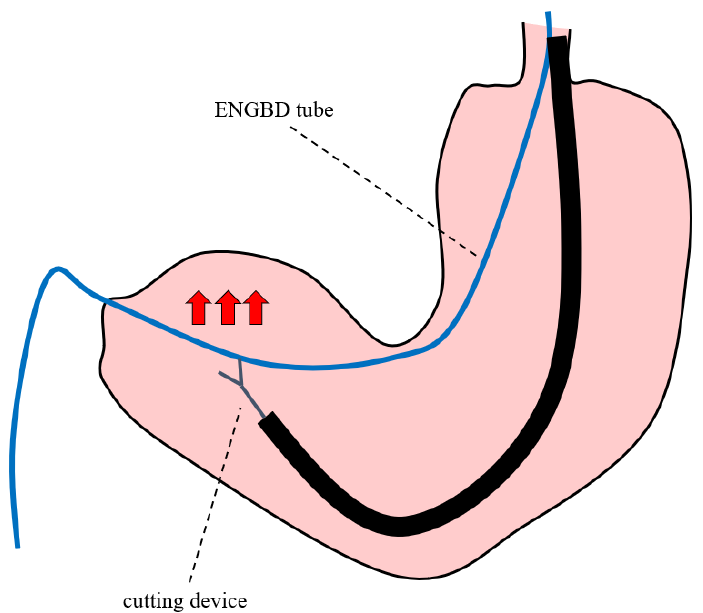
Figure 5. Endoscopic nasogallbladder drainage tube was cut at the antrum of the stomach. Red arrows indicate the direction in which the ENGBD tube is moved during endoscopic cutting.